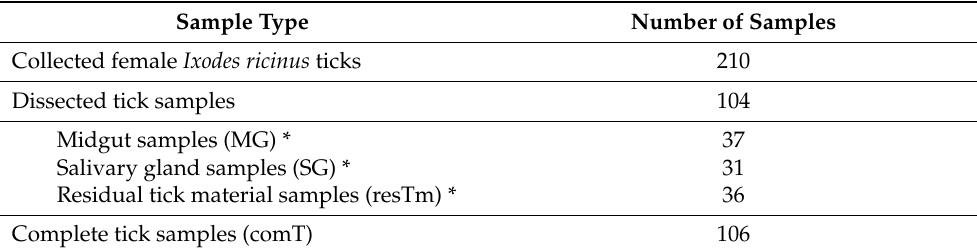
Table 4. Overview of the prepared